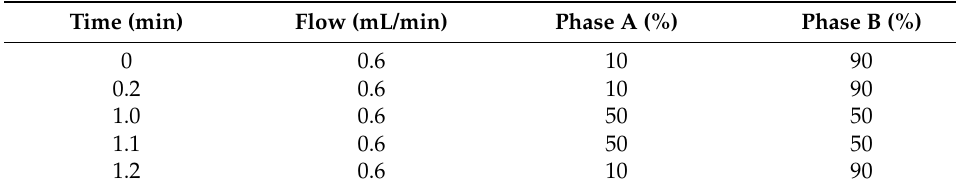
Table 1. Gradient elution for total peptide-22 concentration